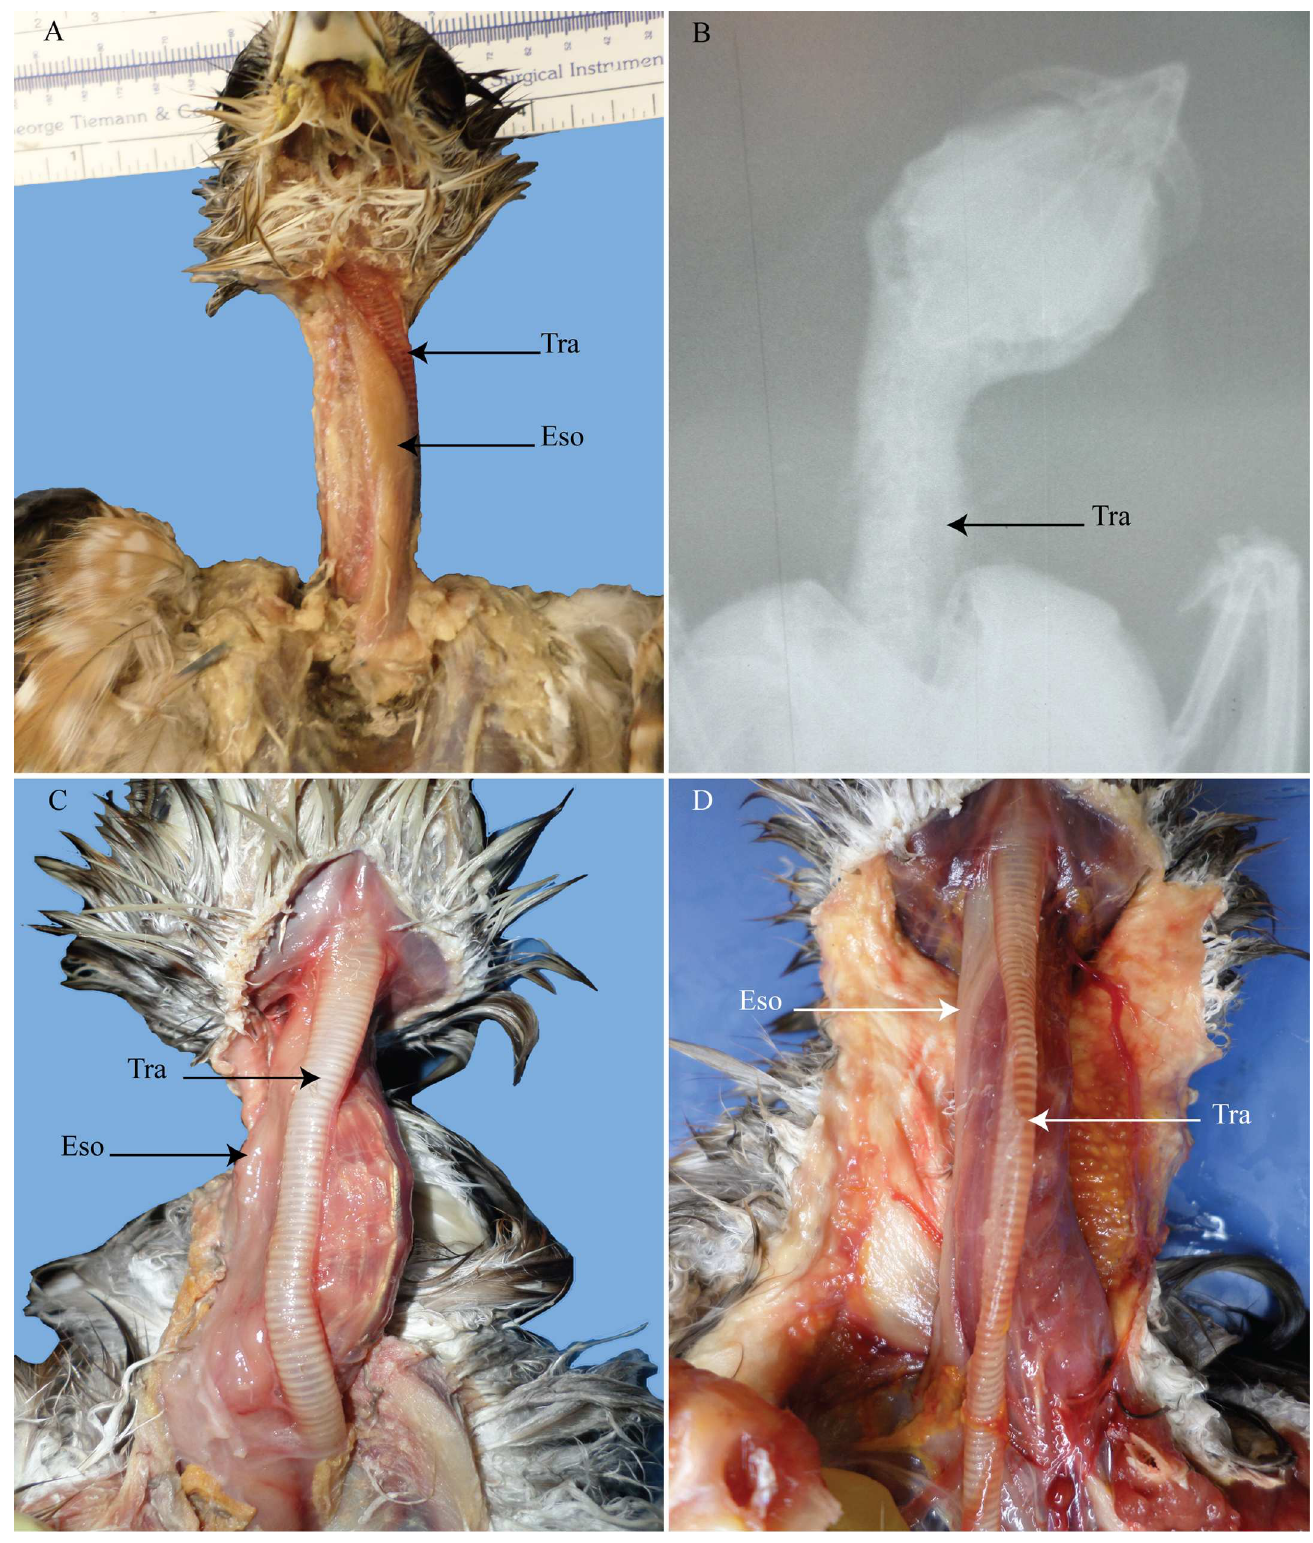
Fig 10. Accipitriformes. (A) Accipiter cooperii placement of the trachea and esophagus are on the left side of the neck. (B) radiograph of A . cooperii also showing the tracheaon the left. (C) Buteo jamaicensis ventral view showing a moretypical rightlateralization.(D) Buteo platypterus ventral view displaying a midsagittal positionof the trachea.The trachea is also twistednearly180°.Tra = trachea; Eso = esophagus.